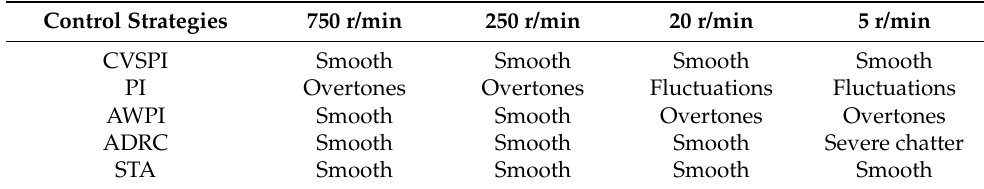
Table 6. Comparison of performance in the broad speed domain. Control